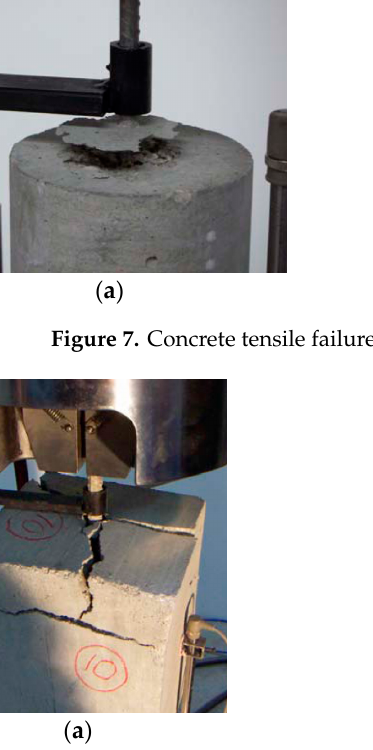
Figure 6. Concrete tensile failure: ( a ) specimen S21; ( b ) specimen S43.